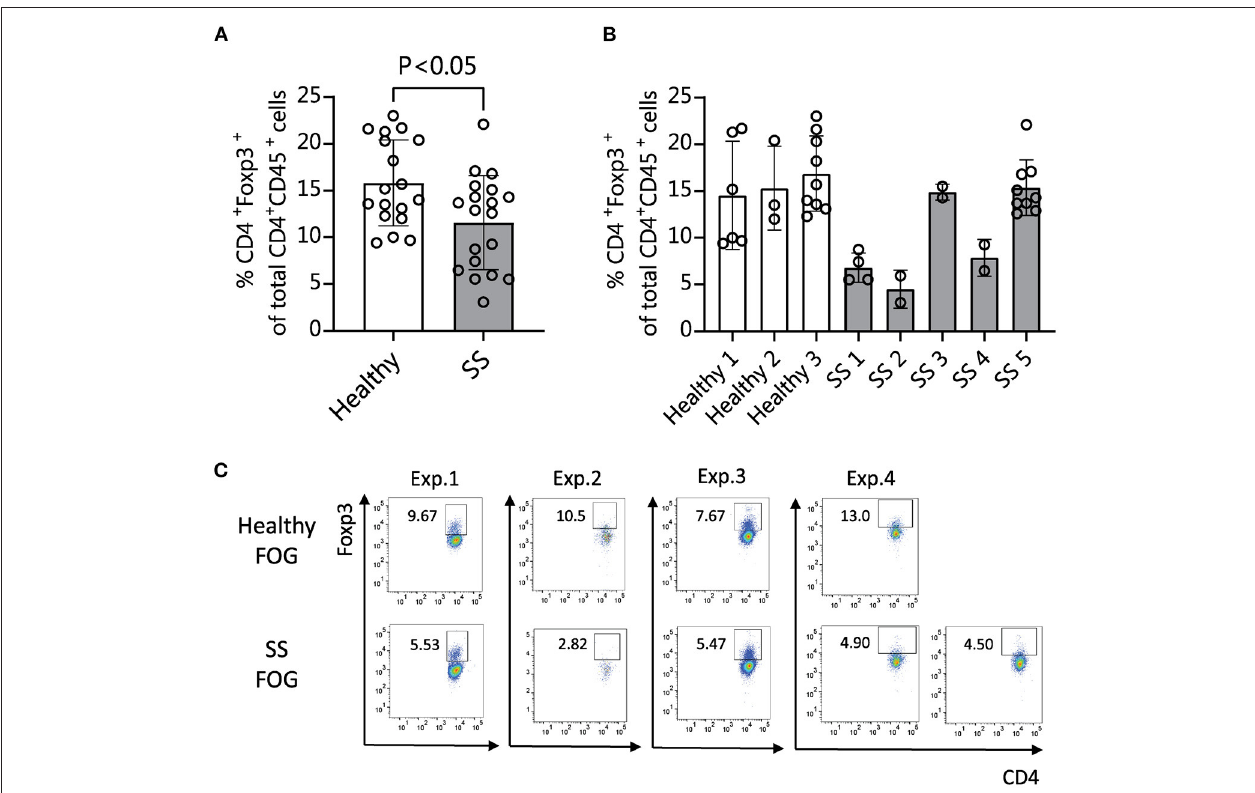
FIGURE 3 | Mice colonized with SS fecal material exhibit fewer CD4 + FOXP3 + cells in cervical lymph nodes (CLN) than mice humanized with normal healthy fecal material. (A,B) 4 weeks after humanization of germ-free mice with patient stools, CLNs were collected for flow cytometry analysis and analyzed for the percentage of CD45 + CD4 + cells expressing FOXP3. (A) Shows the combined data for animals humanized with healthy vs. SS patient stools ( n = 3–5 donors per group). (B) Shows the same data separated by patient donor. (C) Representative flow cytometry data showing CD45 + CD4 + FOXP3 + cell populations in 4 separate experiments using fecal slurries from 5 different SS patients and 4 healthy controls. Exp., Experiment; FOG, fecal oral gavage; SS, Sjögren